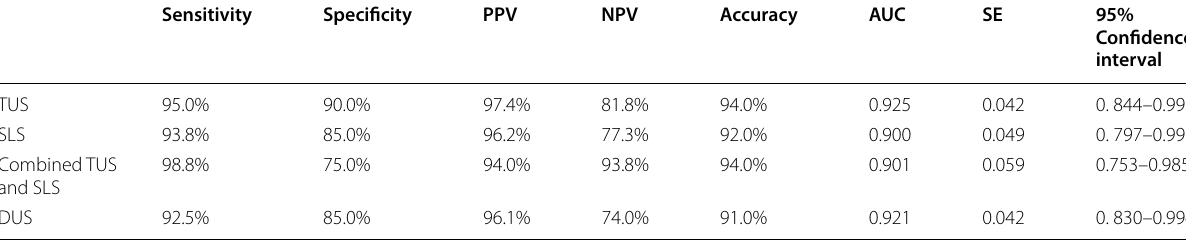
Table 6 The diagnostic test performance of TUS, SLS, and DUS in the confirmation of ETT position